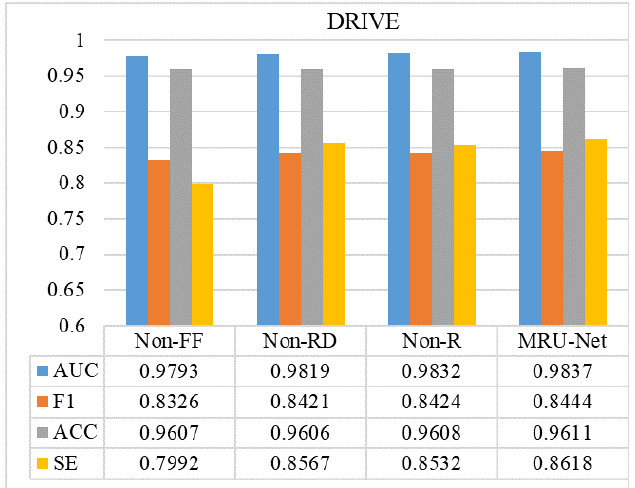
Figure 13. Comparison of DRIVE results: comparison of the indexes of different model structures in our proposed method.